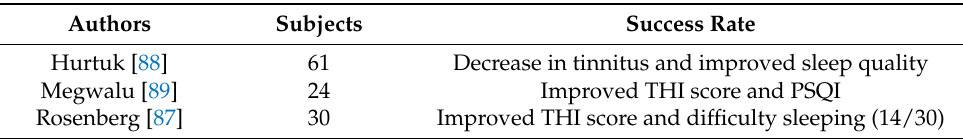
Table 11. Summary of studies that used melatonin to treat